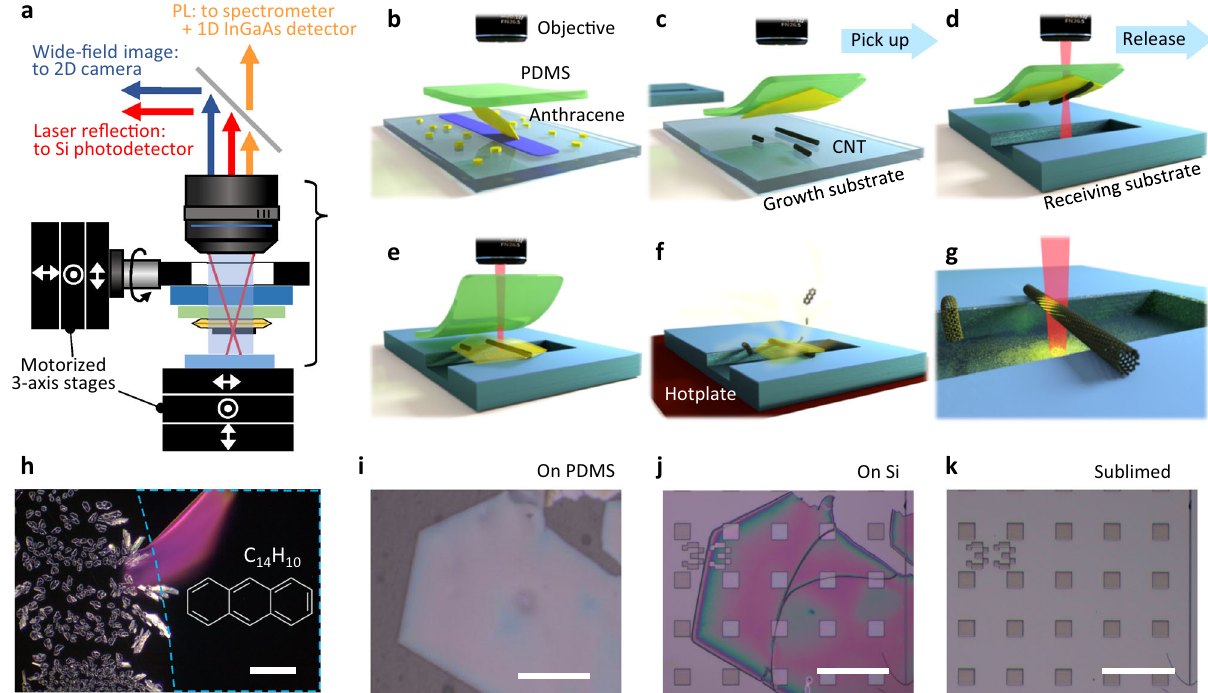
Fig. 1 Procedure for anthracene-assisted dry transfer of carbon nanotubes. a Schematic of the transfer system that simultaneously monitors the nanotube PL, the laser re fl ectivity, and the wide- fi eld image. Substrates and a stamp are mounted on independent 3-axis stages. b Anthracene crystals are grown on glass slides through in-air sublimation and are picked up with a PDMS stamp. c CNTs are picked up with the PDMS/anthracene stamp, d followed by a PL measurement to locate CNTs of interest. e Anthracene/CNTs are released on a receiving substrate by peeling off the stamp. f In-air heating of the substrate removes the anthracene crystals and g leaves behind the CNTs alone. h – k Typical optical images of anthracene crystals grown on a glass slide ( h ), picked up on a PDMS ( i ), transferred to a Si chip with an array of pits ( j ), and after sublimation in air ( k ). Region outlined by a blue dashed box in h is coated with marker ink. Scale bars are 100 μ